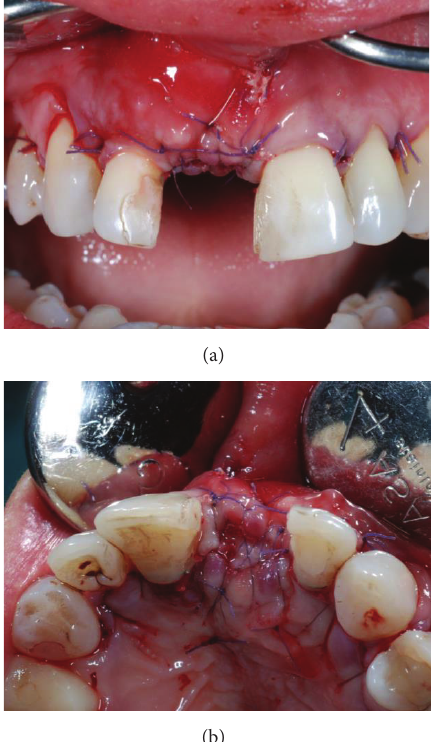
Figure 13: After fixation of the connective tissue graft to the buccal flap (a), Emdogain (cid:3) was applied on the lateral incisor root surface to regenerate the lost periodontal attachment (b).